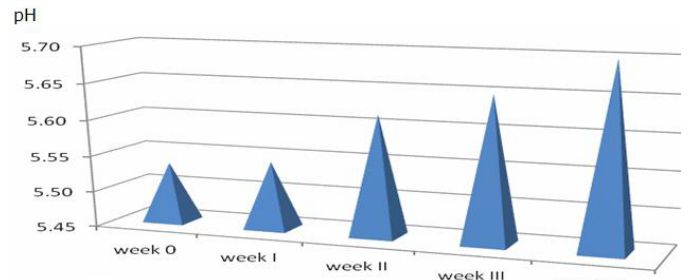
Figure 3. The change of pH value during one month of observation